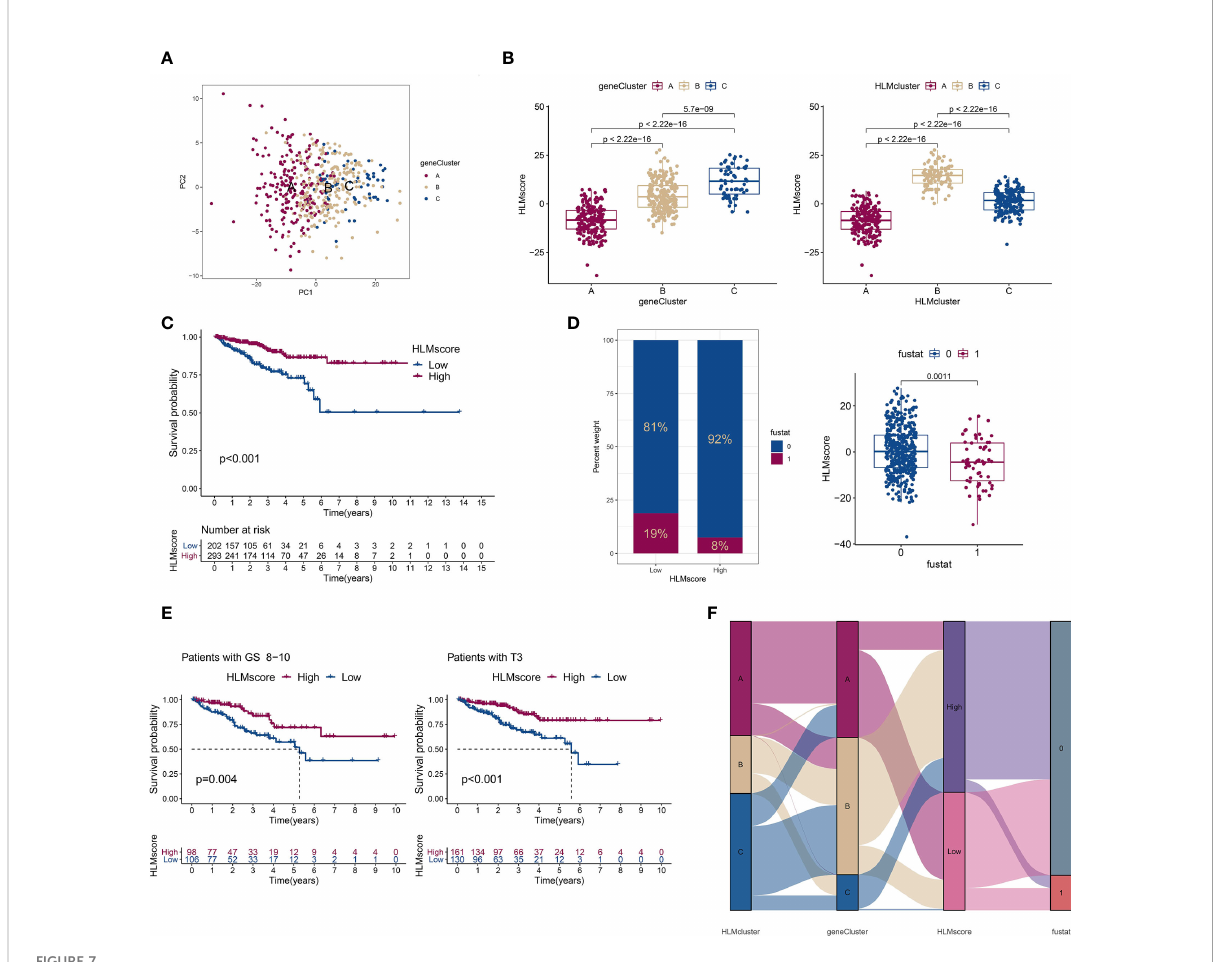
FIGURE 7 The low-HLMscore group based on the 189 HLM phenotype-related genes was associated with poor prognosis in terms of RFS. (A) PCA of the transcriptome pro fi les of 189 HLM phenotype-related genes in three geneGluster patterns. Red, orange, and blue dots in the scatter diagram represent geneClusters A to C, respectively. (B) The HLMscore was calculated via PCA based on 189 gene levels in TCGA-PARD. Then, we compared the levels of the HLMscore among geneClusters (left) and HLMclusters (right). The values of median ± interquartile range and P are shown in the boxplots. (C) TCGA-PRAD patients were divided into two groups (202 with low-HLMscore group and 293 with high-HLMscore group) according to the optimum threshold segmentation of the HLMscore in relation to the lowest log-rank P value in the Kaplan ‒ Meier analysis. RFS analysis of the two HLMscore groups is performed using Kaplan – Meier curves. (D) (left) The proportion among TCGA-PRAD patients of biochemical recurrence status in low- and high-HLMscore groups (fustat of 0: no recurrence; 1: recurrence). (right) HLMscores in the different statuses of biochemical recurrence. The P value of the Wilcoxon test is shown in the boxplot. (E) RFS analysis of the two HLMscore groups among TCGA-PRAD patients with GS 8 – 10 (left) and pT3 (right). (F) The attribute changes of TCGA-PRAD in HLMclusters, geneClusters, HLMscore, and recurrence status are shown as an alluvial